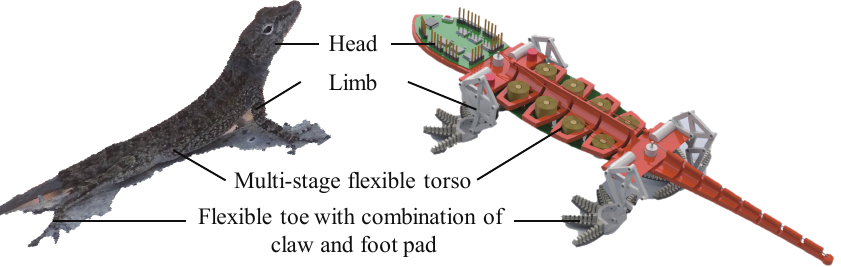
Figure 6. Design diagram of robot that imitates an anole lizard. Based on the the continuous deformation ability of anole lizard toes, three long phalanx bones are evolved into phalanx bones with continuous changes in height, and traction lines are passed through the middle of each phalanx bone to imitate muscle. The toe